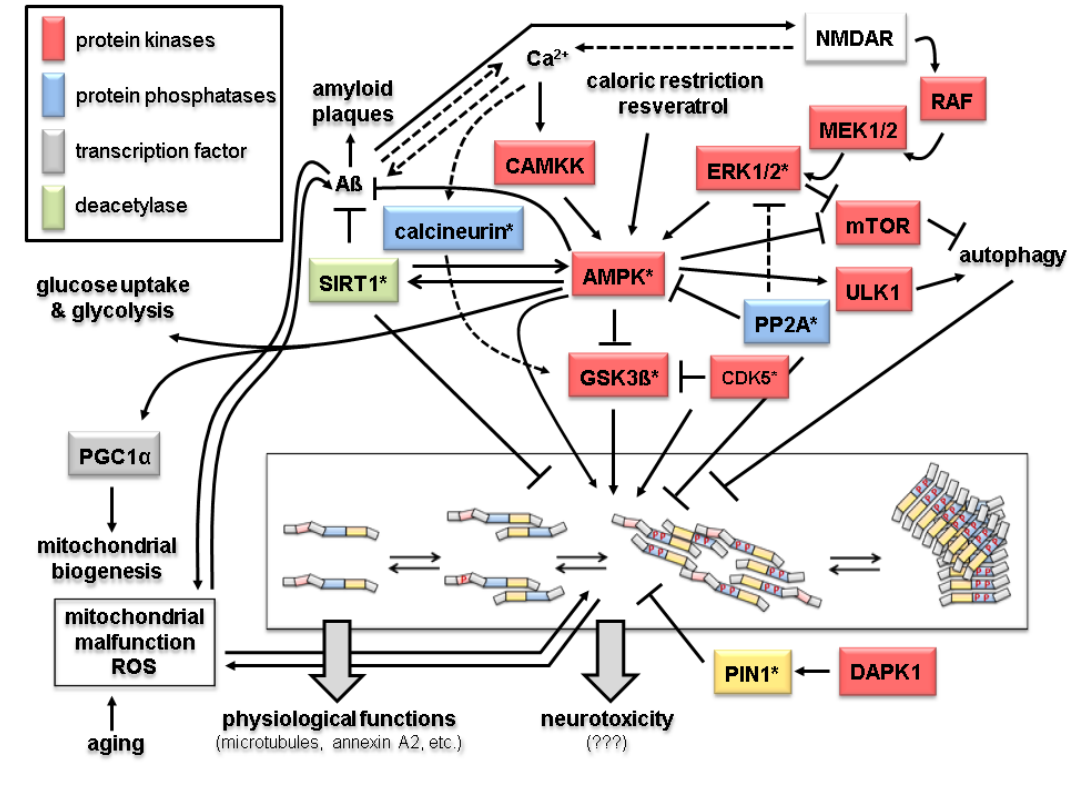
FIGURE 2: Signaling and modification pathways influencing the intracellular concentration of the toxic oligomeric forms of tau. Arrows indicate activa- tion of enzymes or promotion of a conformational change, lines with bars indicate their inhibition/inactivation. Different protein functions are colour- coded as shown in the upper left hand corner. Schematic representation of tau oligomerization states (central lower part) is as in Fig. 1B. Enzymes with homologs in yeast discussed in the text are marked by an asterisk. Question marks with the neurotoxicity output indicate that the exact molecular mech- anisms leading to that condition are not known. Despite the number of different protein functions and signaling cascades displayed in this scheme, not all possible components and interacting networks influencing tau oligomerization are shown. Neither are all possible crosstalks between the depicted components shown (e.g. the protein phosphatase PP2A will also inactivate the upstream components of the ERK1/2 MAPK cascade, calcineurin also acts directly on phosphorylated tau, and PIN1 regulates the activities of GSK3ß and AMPK). In the following, the different signaling pathways which affect tau aggregation are briefly summarized. 1. Activation of tau-phosphorylating protein kinases. The glycogen synthase kinase GSK3ß phosphorylates tau and promotes its aggregation [31]. The kinase activity of GSK3ß is inhibited upon its phosphorylation by the cyclin-dependent protein kinase CDK5, which can also phosphorylate tau, thus either preventing or promoting tau aggregation, respectively [32]. The trimeric AMP-activated kinase complex AMPK phos- phorylates and thus inhibits GSK3ß, but can also itself phosphorylate tau and promote its aggregation [33, 34]. The catalytic subunit of AMPK itself is activated by phosphorylation, which can be catalyzed either by the calmodulin-dependent protein kinase kinase CAMKK or a redundant pair of mitogen activated protein kinases (MAPKs), designated as extracellular signal recognition kinases ERK1 or ERK2 [35, 36]. Whilst CAMKK is activated by Ca 2+ -bound calmodulin, activation of ERK1/2 is triggered through a conserved MAPK cascade, consisting of the MAPKKs MEK1 and MEK2 and the MAPKKK RAF. Both branches are dependent on the function of the glutamate receptor NMDAR, which triggers an intracellular increase in calcium concentration. This results in the activation of CAMKK and indirectly of RAF through activation of a Ras-GDP/GTP exchange factor (GEF) not depicted here [37]. AMPK, and thereby its inhibitory effect on GSK3ß and tau aggregation, can also be activited by caloric restriction and antioxidants like resveratrol through their influence on the intracellular energy state, i.e. by changing the AMP/ATP ratio [38]. 2. Protein phosphatases. Only two major protein phosphatases which influence tau aggregation are depicted in this scheme, PP2A and calcineurin. Their roles in AD have been reviewed in [39]. Briefly, calcineurin, also called